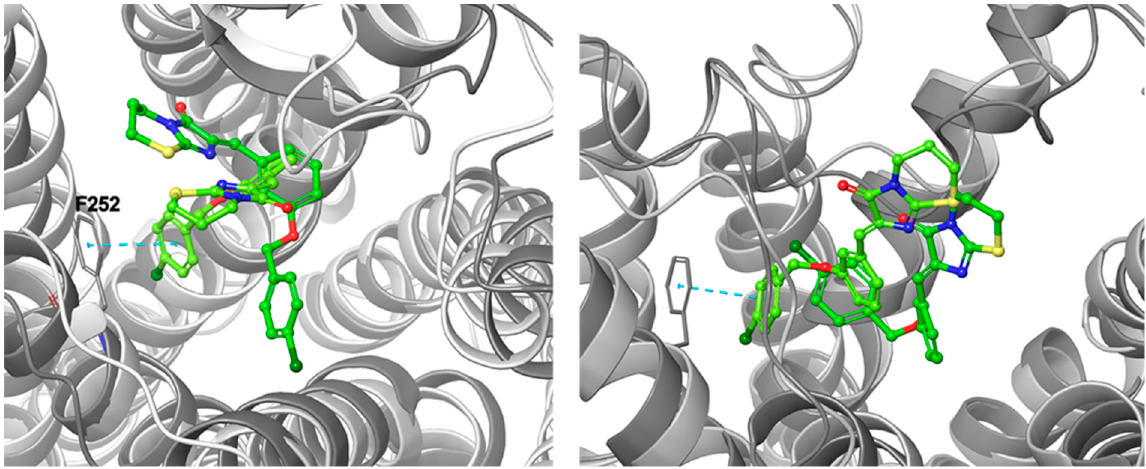
Figure 11. Orientations of CB5 in IT ( left panel ) and TTA ( right panel ) models at 0 ns (green) and after 10 ns of simulation (lime green). For a colored figure, please refer to the online version of this paper.